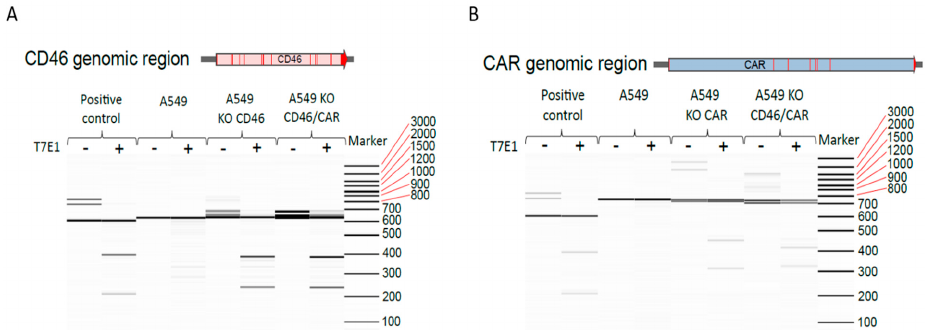
Figure 5. Analysis of the genome-edited CD46 and CAR loci in A549 cells. ( A ) To further confirm genome editing at the CD46 target locus, a T7 endonuclease I (T7EI) assay was performed. For this